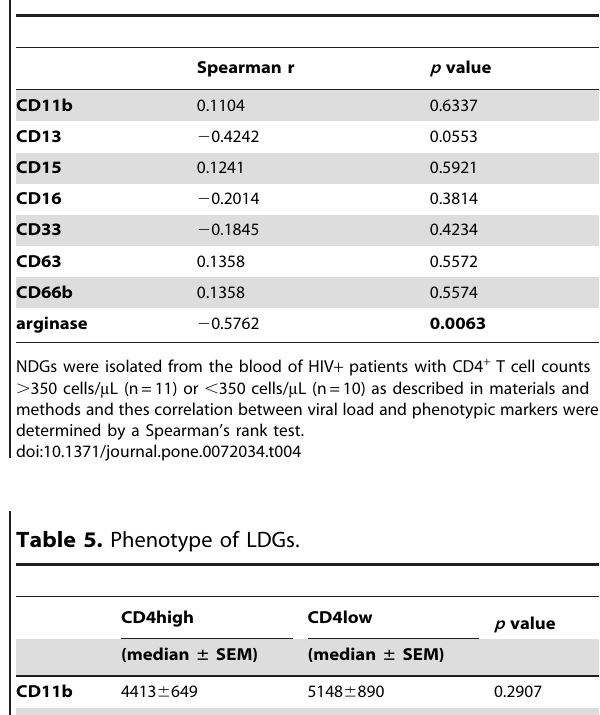
Table 4. NDGs: Correlation between viral loads and MFIs.